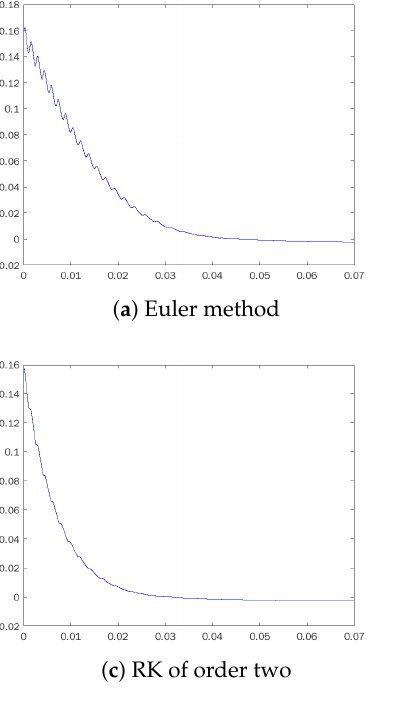
Figure 6. Lyapunov function h = 10 − 5 .